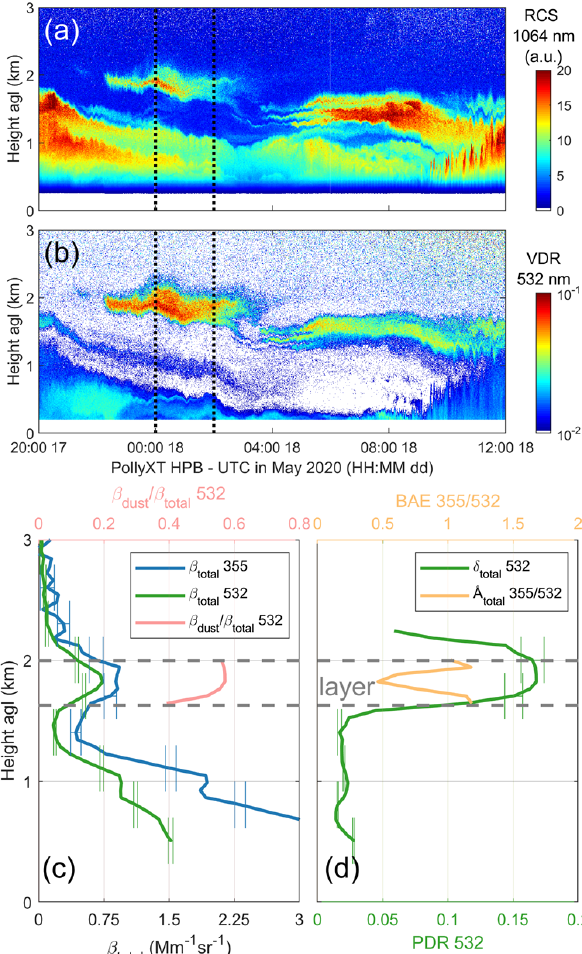
Figure 6. Similar to Fig. 5 but in period no. 2 of Hohenpeißenberg